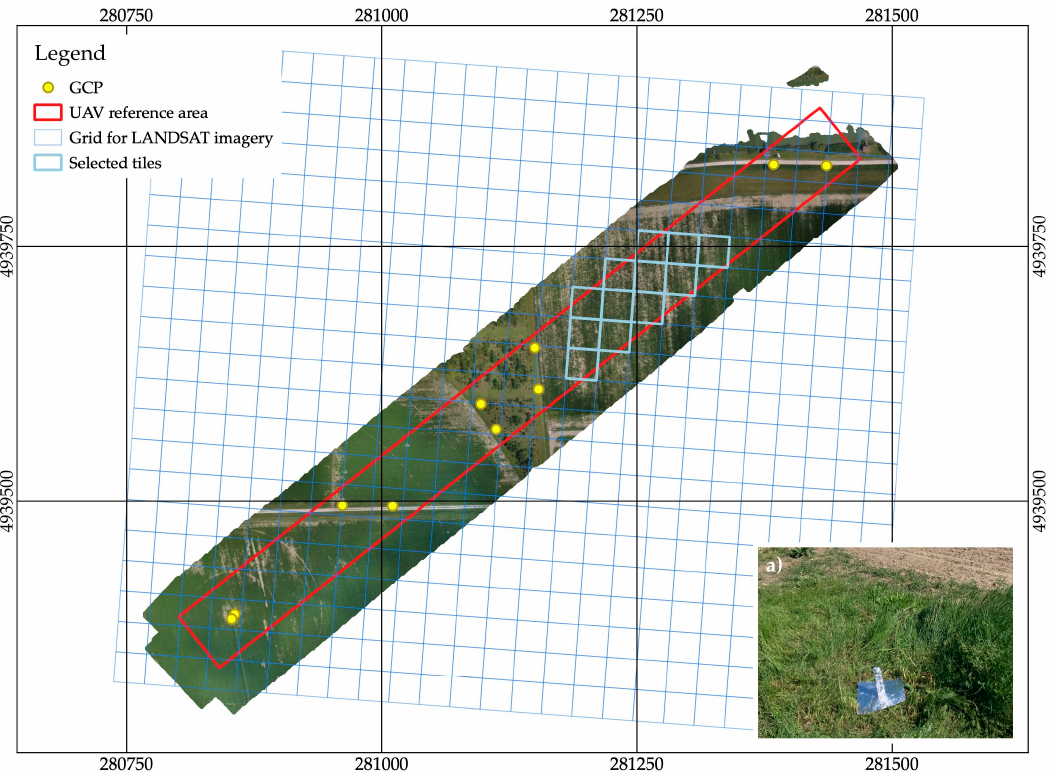
Figure 2. Reference area for UAV surveys is highlighted with a red polygon. The Landsat-8 grid of 30 × 30 m pixels at ground level in path 192 is overlaid in light blue. The 12 selected tiles discussed in this paper are highlighted. The orthophoto is produced from images acquired on July 19 accurately geo-referenced with 10 ground control points (GCPs) thermal target (a). Grid coordinates are UTM-ETRS89 Zone 33T. The Reno river is visible at the NE end of the